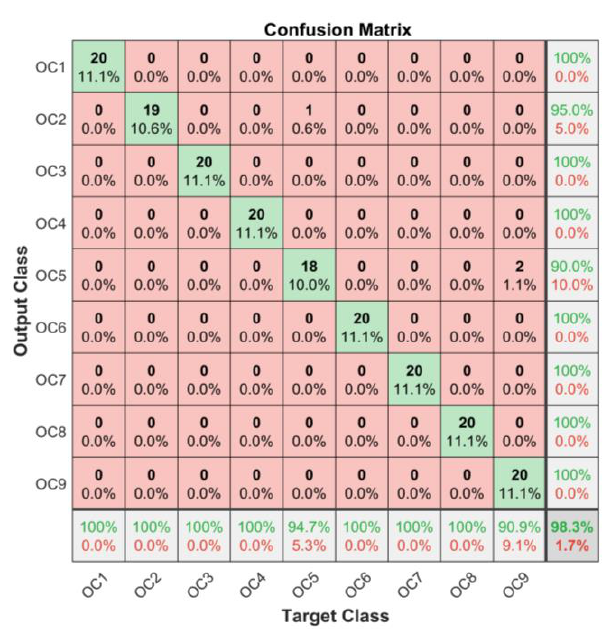
Figure 10. Confusion matrix of test results.